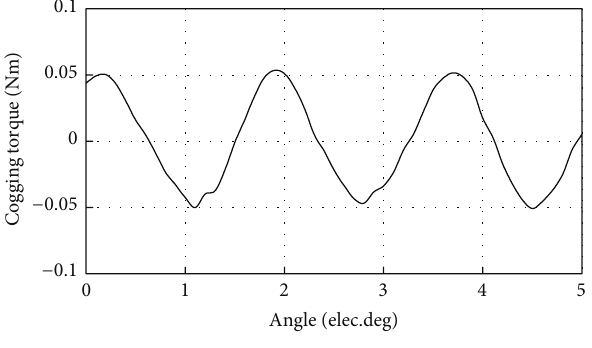
Figure 4: Cogging torque